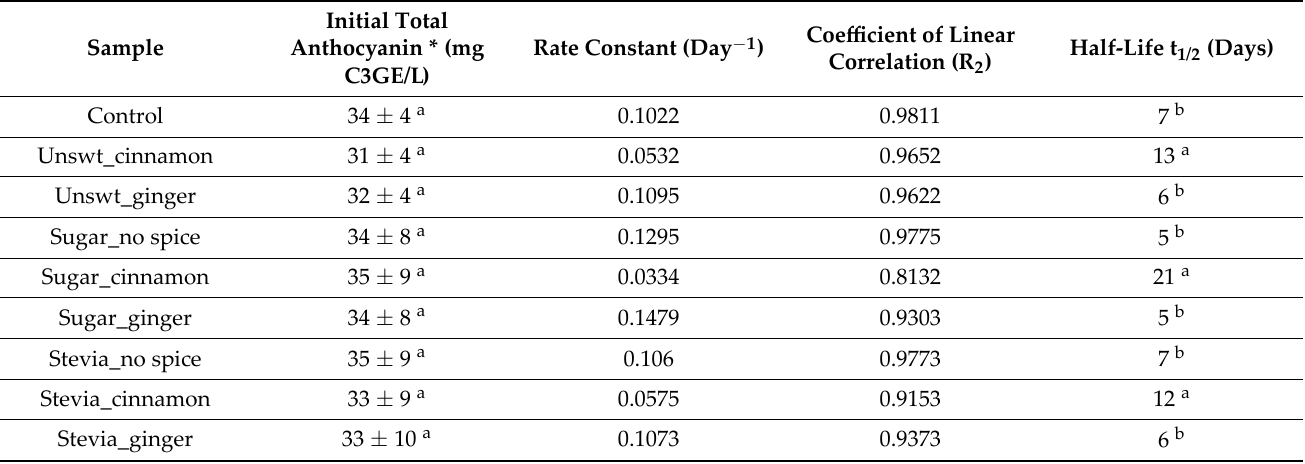
Table 2. Total anthocyanin kinetics data for unsweetened (control), sweetened, and spice‑flavoured Roselle beverages ( n = 9) stored under accelerated conditions (40